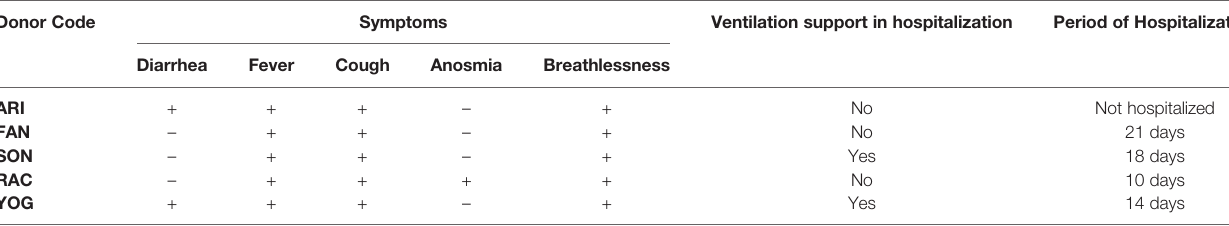
TABLE 2 | Clinical features of repetitive convalescent plasma